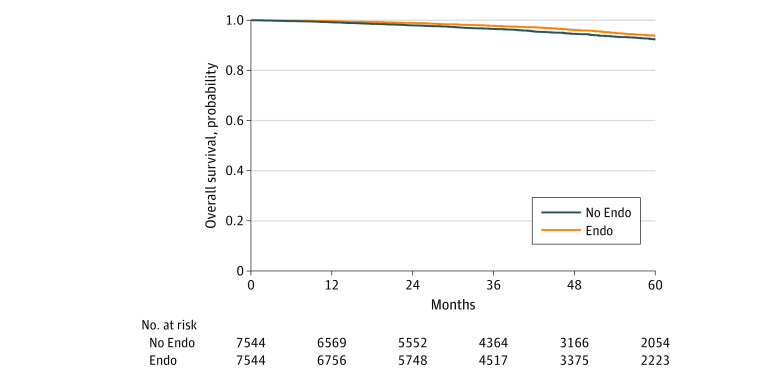
Kaplan-Meier Survival Curve After MatchingEndo indicates endocrine therapy.